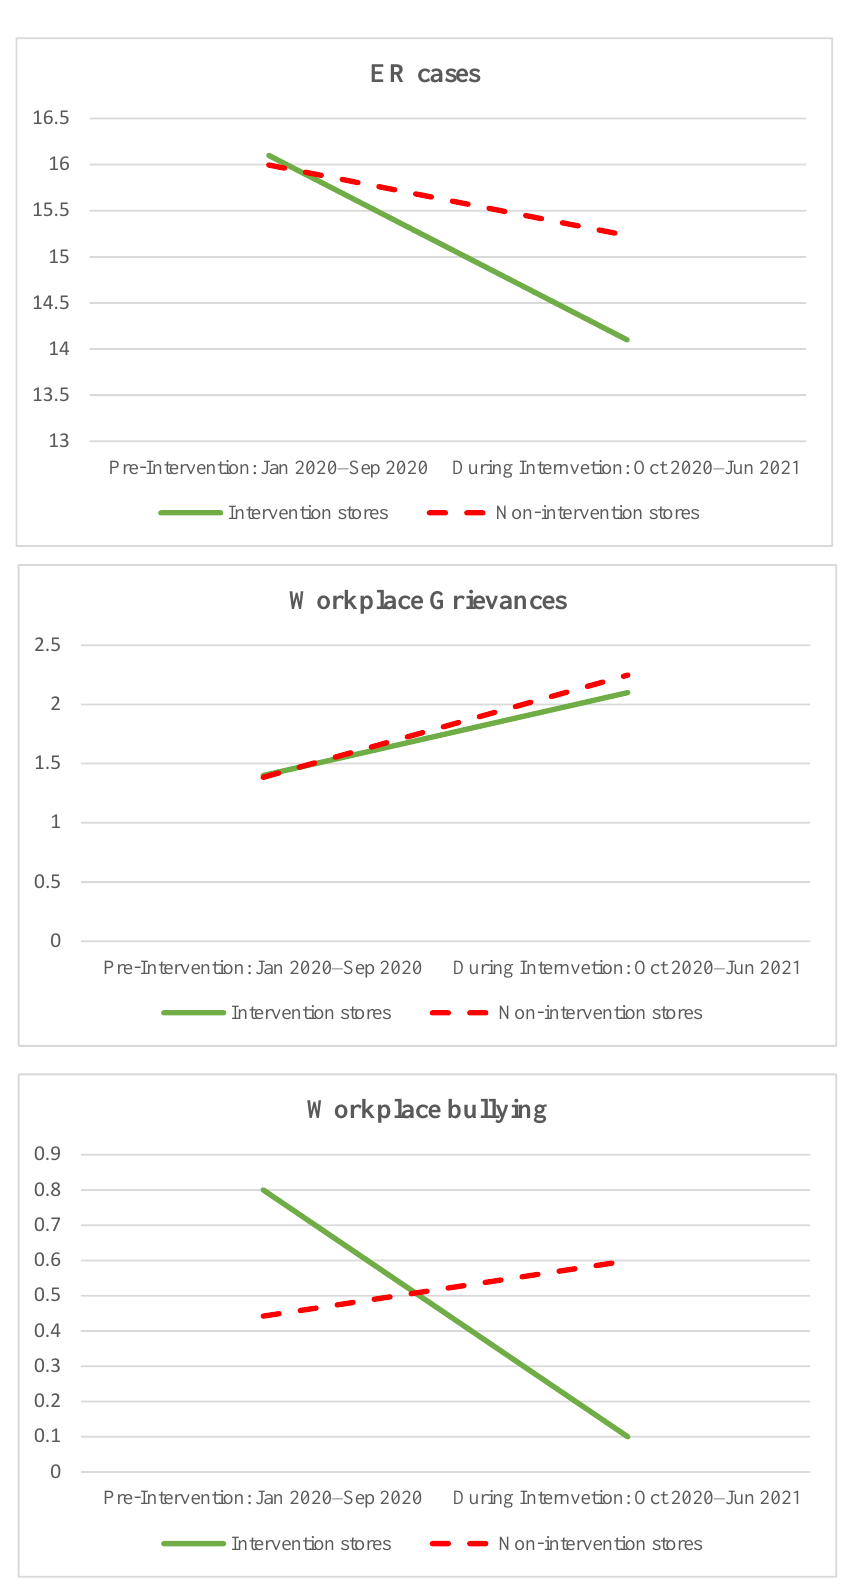
Figure 1. A comparison of company internal complaint records between intervention stores and stores of the same organisation that were not exposed to intervention.